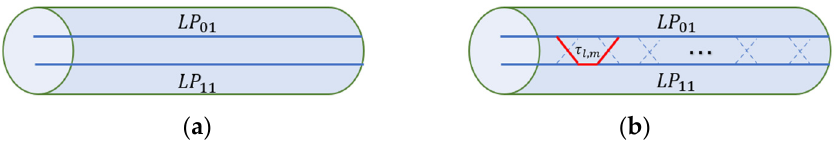
Figure 1. ( a ) The optical modes in ideal FMF; ( b ) the optical modes in real